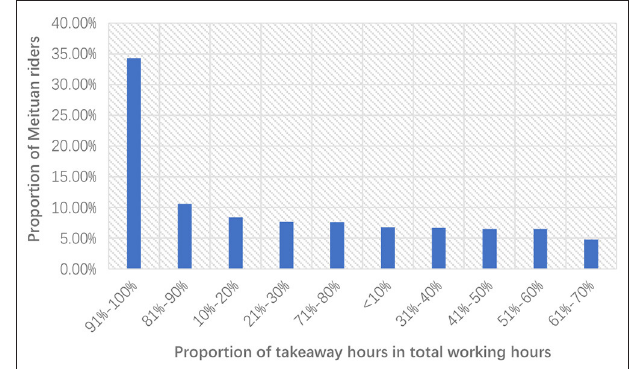
FIGURE 6 | The top5 province with the most local riders.